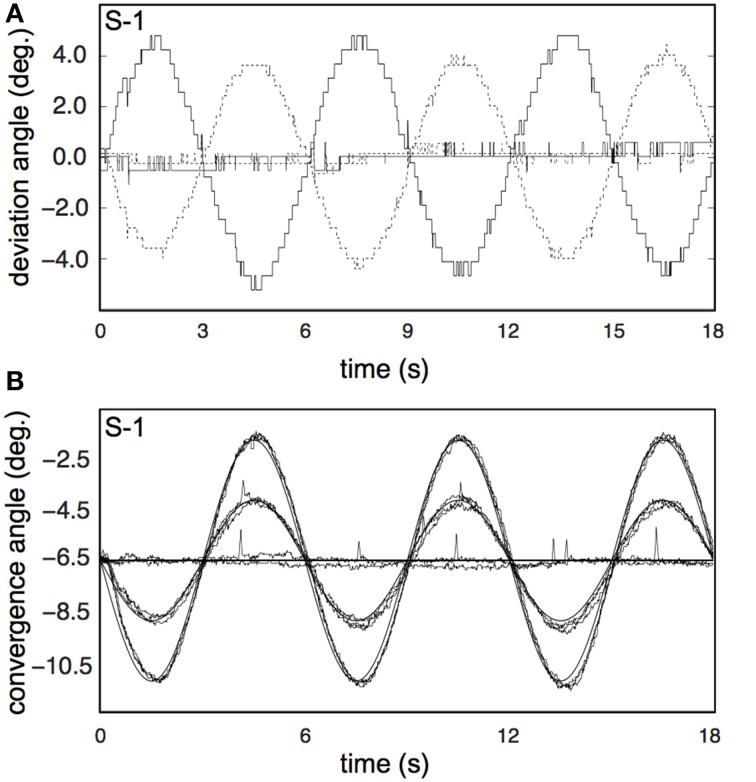
Results for the vergence eye movement recordings. (A) Raw traces of eye pursuit in depth measurements from subject S-1, for one of the high vergence conditions (V4R0H4, bold lines), and one of the non-vergence conditions (V0R0H0, normal lines). Dotted lines represent left eye traces; solid lines represent right eye traces. The apparent low sample frequency is due to the manual calibration of the Eyelink system (see Materials and Methods). (B) Pursuit eye movements in depth from S-1, for all 8 conditions. Each trace shows the average of all repetitions for that condition, after blink removal and linear drift correction. Bold lines represents fixation movement in depth for V = 2 and V = 4.